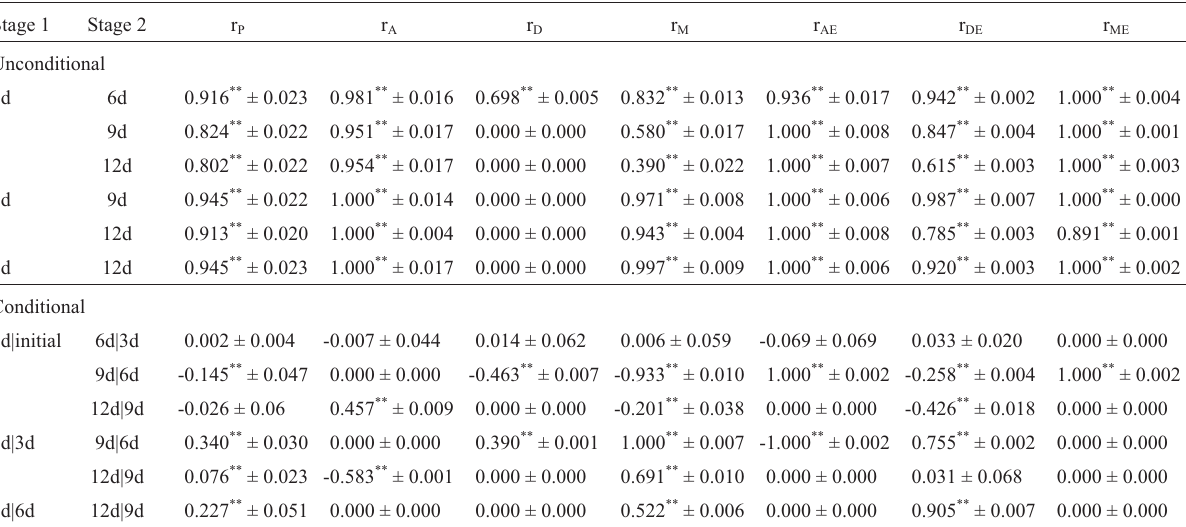
Table 5 - Estimation of unconditional and conditional correlation coefficients for sponge gourd ( Luffa cylindrical (L) Roem.) fruit circumference at four stages of maturation. Stage